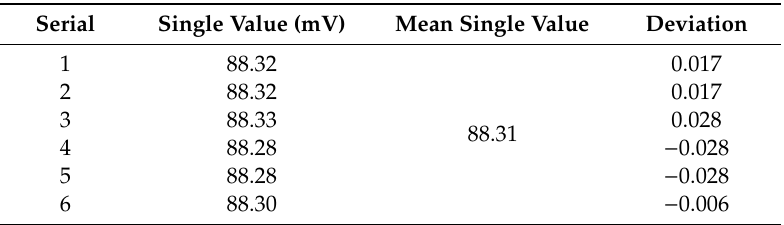
Figure 10. Spot images of serum reaction. Table 2. Light reflection signal values of dry chemical diagnostic reagents in